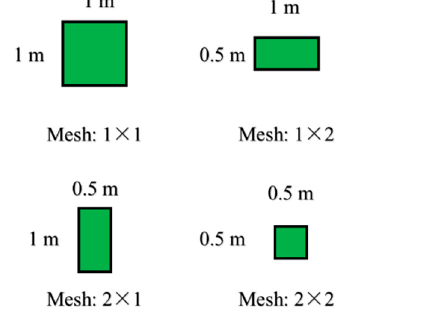
Figure 4. Horizontal mesh size of refinement.